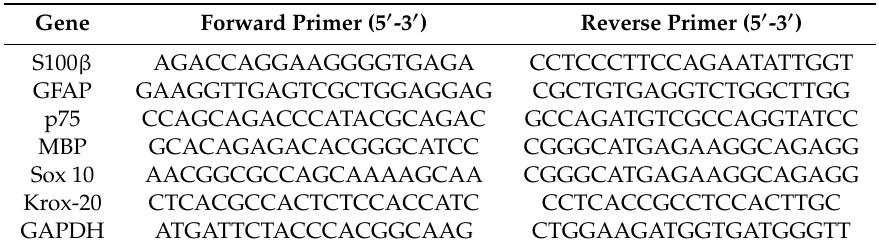
Table 1. Primer sequences for